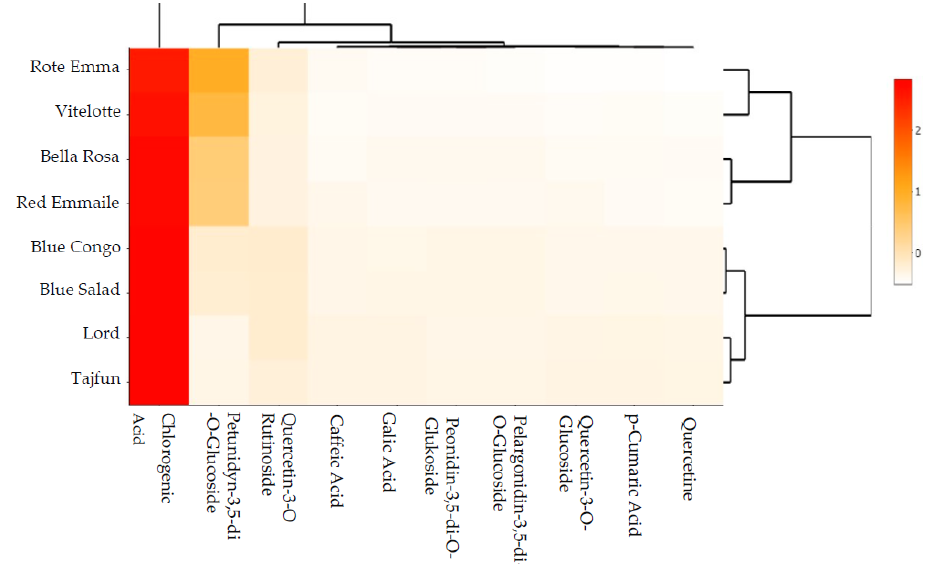
Figure 2. Scaled heat map for potatoes with different skin and flesh colours in terms of polyphenolic and anthocyanin content. Darker colour means greater dependence between research factors (higher correlation coefficient). The diagrams on the outside are the reference for cluster analysis.